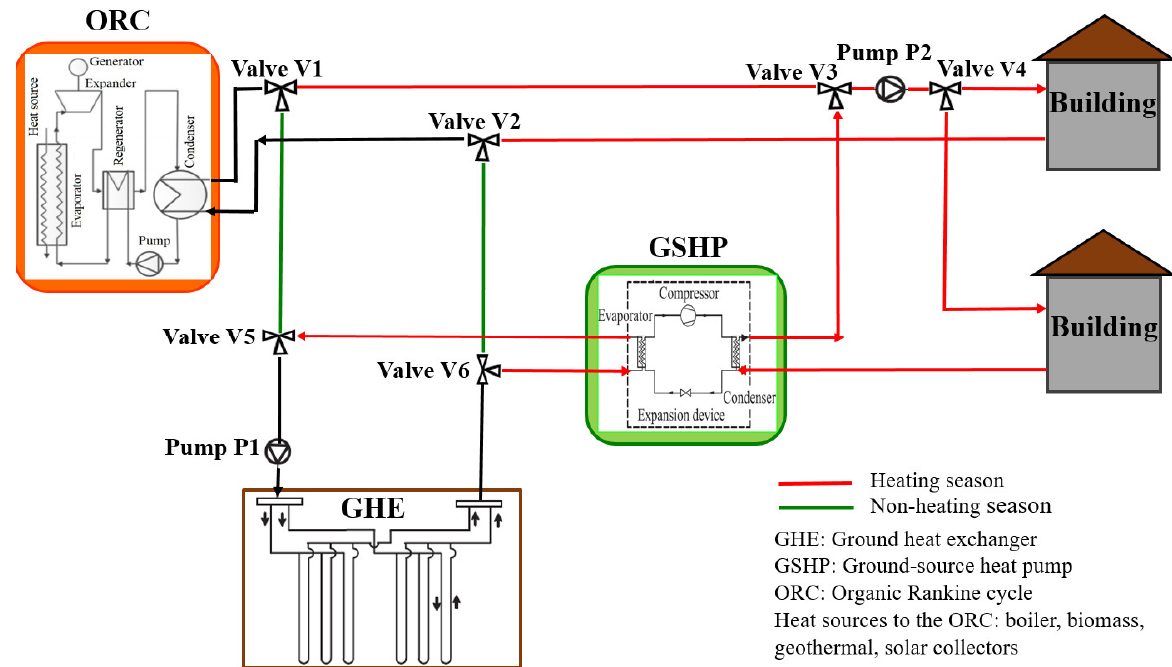
Figure 1. Schematic of the proposed ORC-GHE-GSHP micro-cogeneration